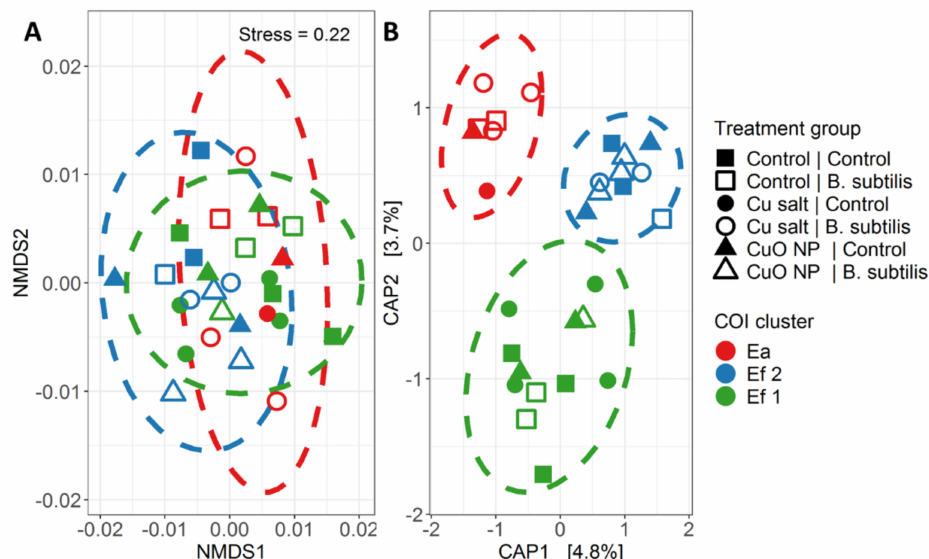
Figure 4. ( A ) NMDS plot showing ordination of ‘bacterial challenge day 2’ samples. ( B ) First two-axis of distance based redundancy analysis (db-rda) including ‘pre-treatment exposure’, ‘bacterial challenge treatment’, and ‘genotype’ as explanatory variables. Percentage following axis labels in ( B ) indicate percentage of total inertia explained by the respective axis. In both figures, di ff erent colours indicate di ff erent COI genotypes, while di ff erent shapes and filling indicate di ff erent treatments. Ellipses indicate 90% confidence interval (CI) of the respective COI cluster. In the legend, the text before the vertical bar indicates ‘pre-treatment exposure’ and the text following the vertical bar indicates ‘bacterial challenge treatment’. ‘Ea’ ( E. andrei ), ‘Ef1’ ( E. fetida 1), and ‘Ef2’ ( E. fetida 2) indicate COI